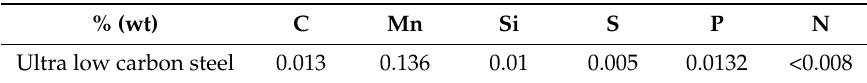
Table 2. Chemical composition of ultra low carbon steel.